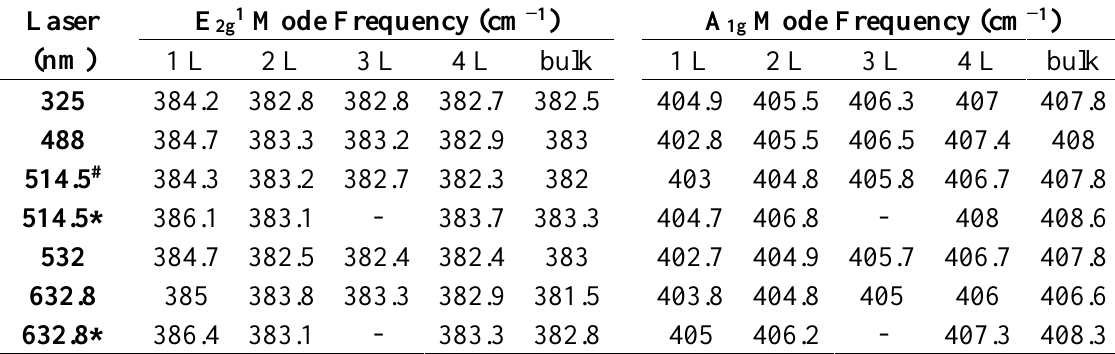
Table 3. Summary of the E 2g1 and A 1g mode frequency of MoS 2 as excited by different laser sources and varied by the number of layers [91]. The 514.5 # nm data is extracted from C. Lee et al. [82]. The 514.5 nm* and 632.8 nm* data only have 1/2/4/7/bulk layers